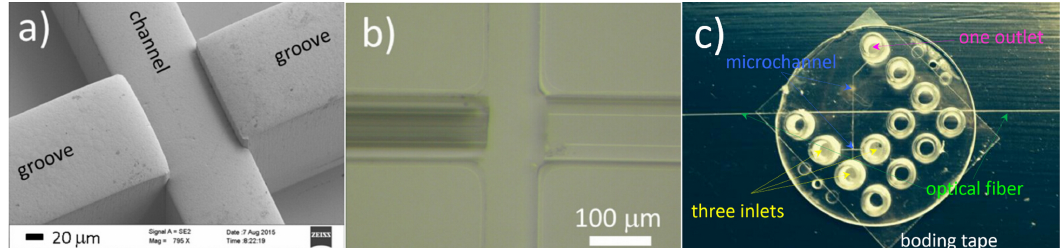
Figure 4. The polymeric assembled optical stretcher. ( a ) SEM image of the Ni shim at the area where the fiber grooves meet the channel. Higher position of the fiber grooves with respect to the central channel will lead to the lower position of the fibers after insertion; ( b ) Bright filed microscope image of the chip at the same area with a photonic crystal fiber (left) and single mode fiber (right) inserted; ( c ) The finished chip ready for use. The three inlets are for hydrodynamic focusing purpose. Figure reproduced from Reference [30] under CC-BY 4.0